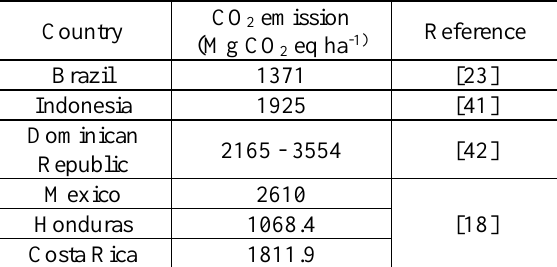
Table 2. Blue carbon emission of different countries related to mangrove degradation CO 2 emission Country Reference (Mg CO 2 eq ha -1)